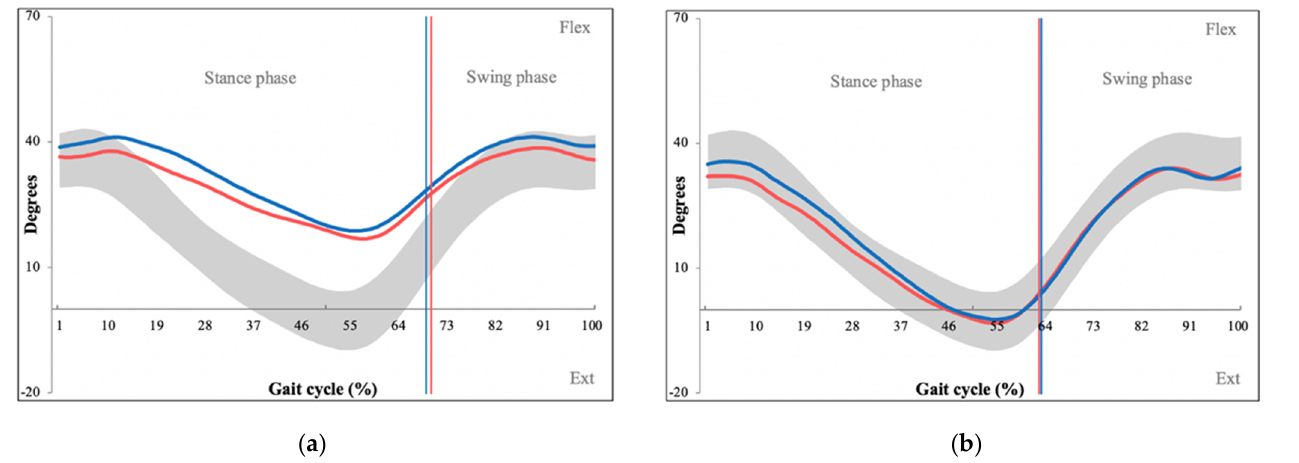
Figure 5. Kinematic graphs of hip flexion/extension of a patient with LSS ( a ) and their matched control ( b ), demonstrating limited hip extension during the stance phase. Degrees of movement are shown on the vertical axis whereas the horizontal axis portrays the gait cycle. (Red line—left leg values, blue line—right leg values, grey space—normative values for hip flexion/extension.) Statistically significant differences were also found in hip abduction/adduction (PG = 5.73, CG = 3.73, p = 0.012), with kinematic graphs showing a decreased range of both abduction/adduction, more so for abduction, which was lower throughout the entire gait cycle (Figure 6).